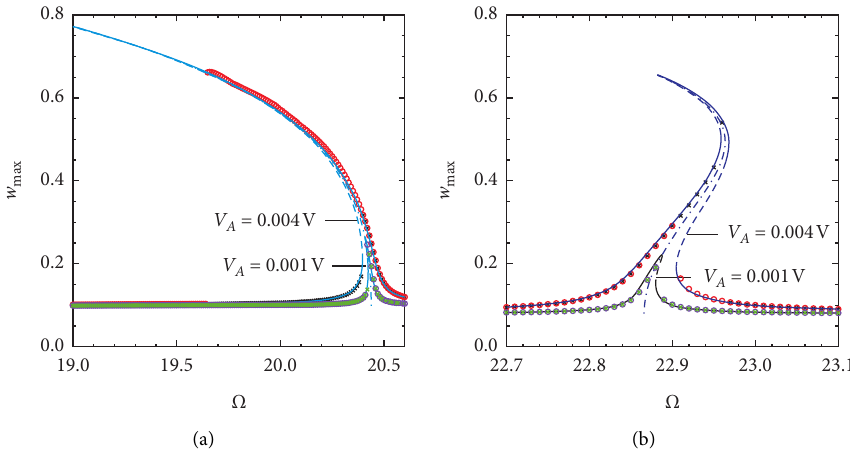
Figure 14: Amplitude-frequency curve: V